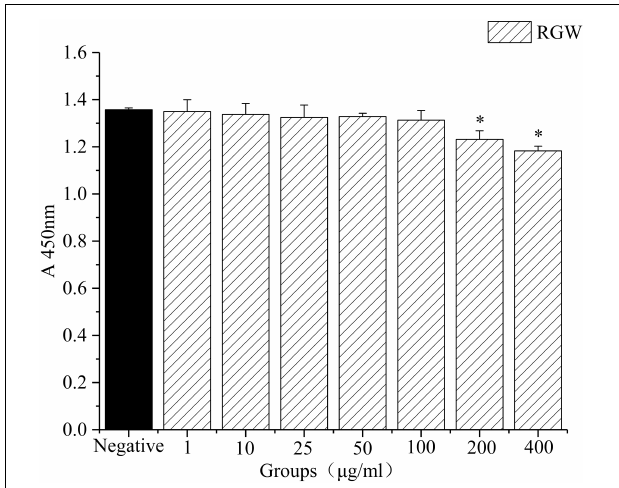
FIGURE 5 | Effect of RGW on HepG2 cells. ∗ p < 0.05 vs.